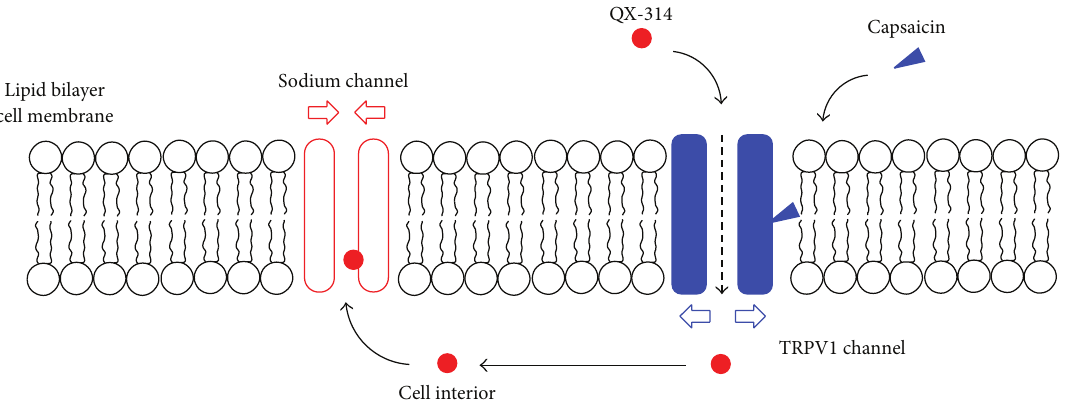
Figure 6: Combined use of QX-314 and